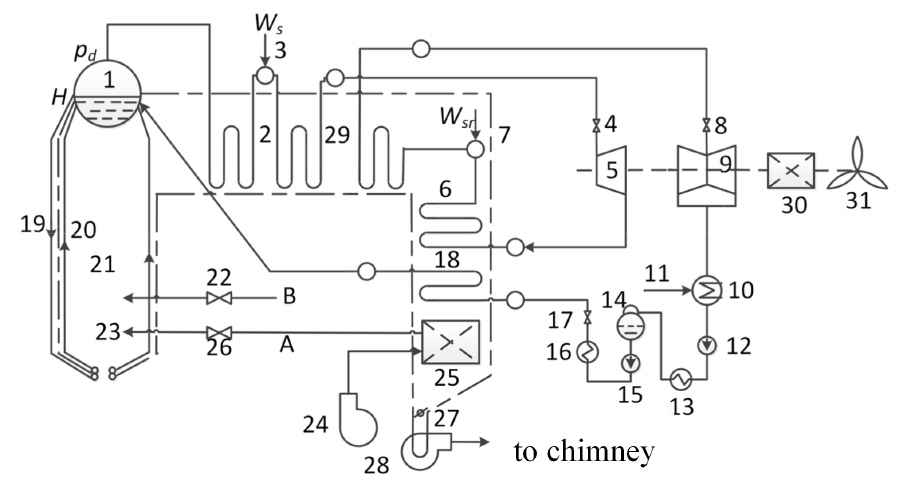
Figure 1. The structure of a boiler-turbine